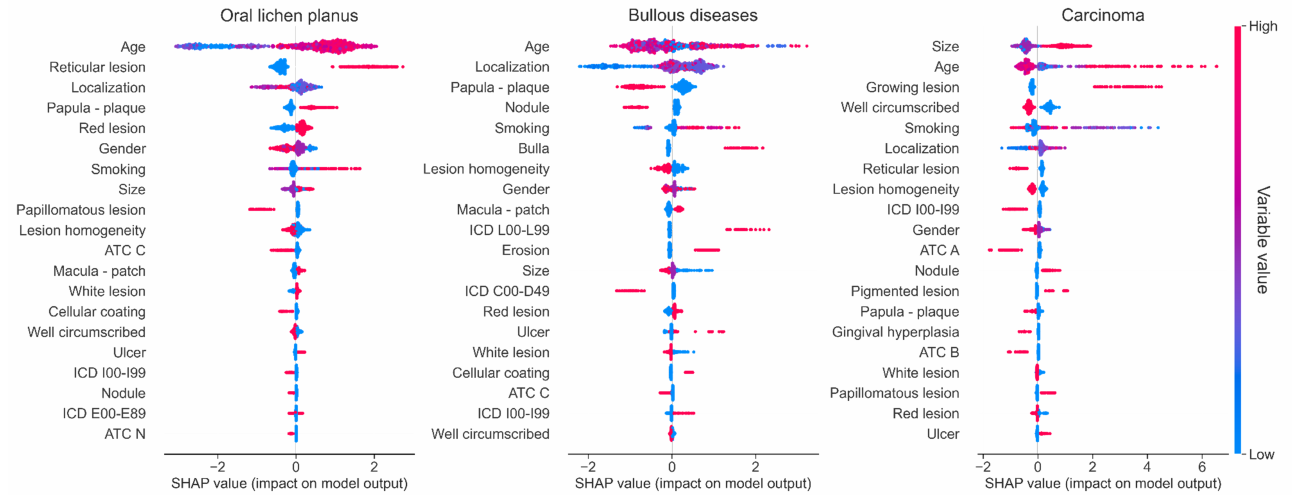
Figure 2. Summary plot of feature importance for each diagnostic prediction for Oral lichen planus, Bullous diseases and Carcinoma. Each point on the summary plot is a SHAP value for a given feature and instance. The position on the y-axis is determined by the feature and on the x -axis by the SHAP value. The color represents the value of the feature from low to high. Overlapping points are jittered in y -axis direction, so we get a sense of the distribution of the SHAP values per feature. The features are ordered according to their importance. Abbreviations: ATC A, Anatomical Therapeutic